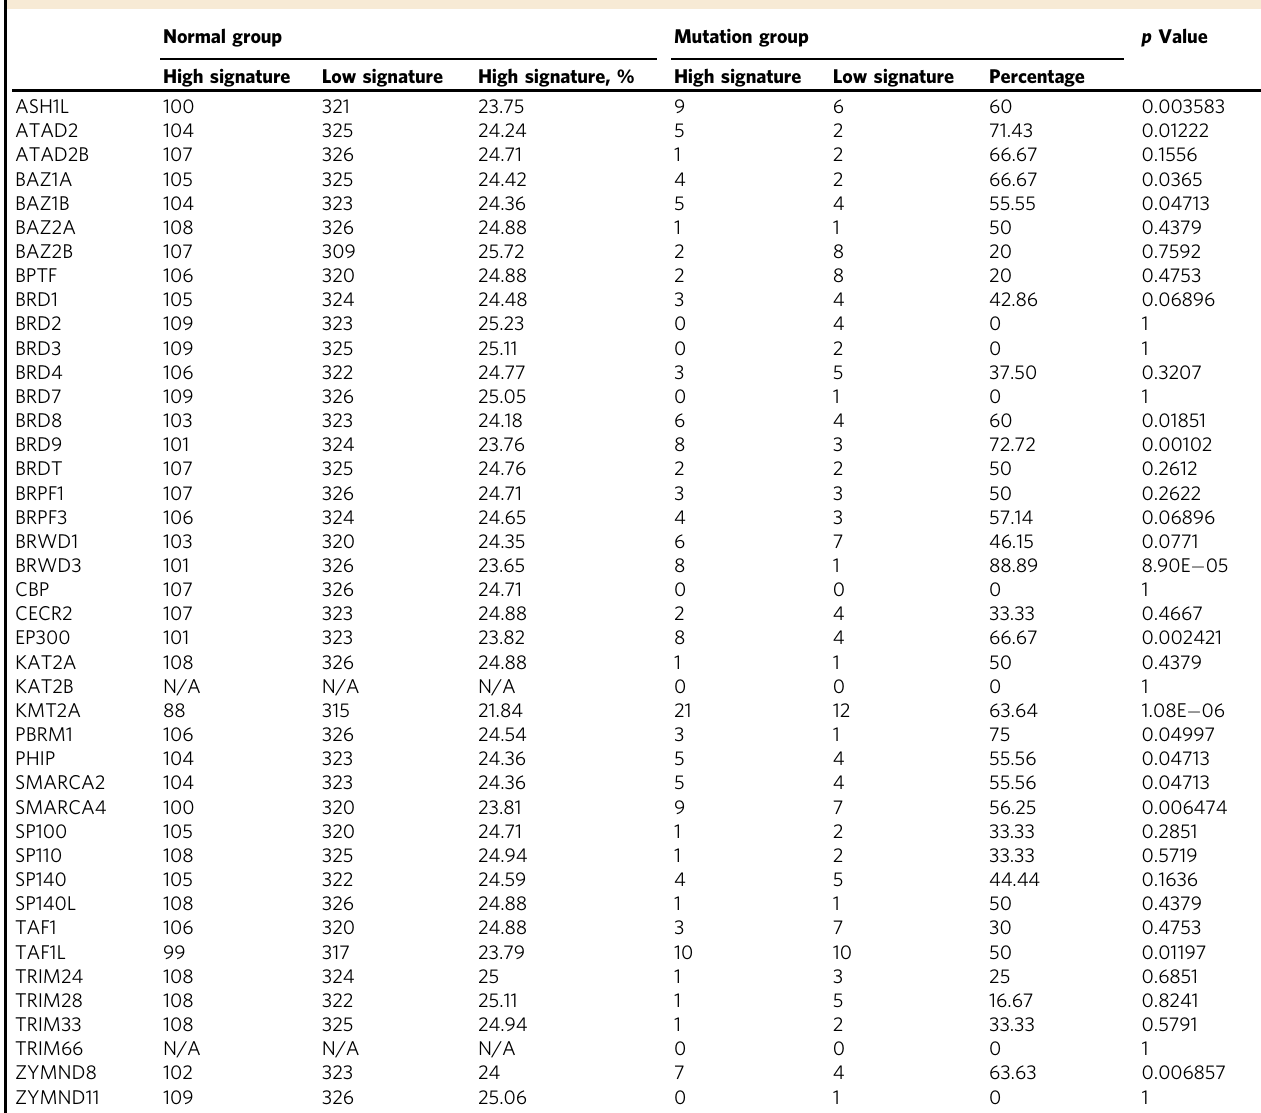
Table 1 Bromodomain-containing protein – HR